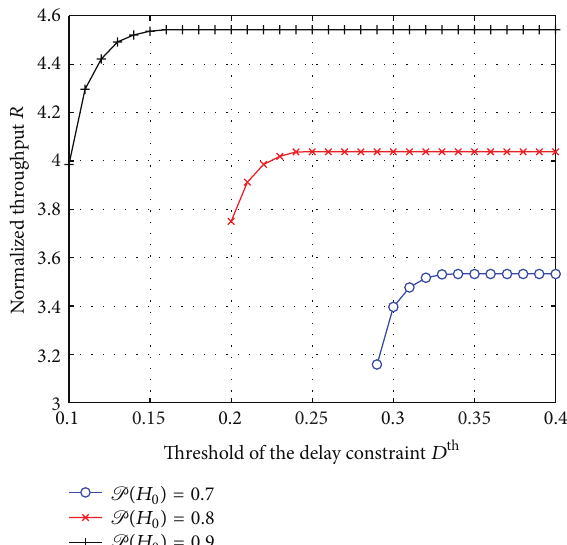
Figure 6: Normalized throughput R versus threshold of the delay constraint with different values of P (𝐻 0 ) .